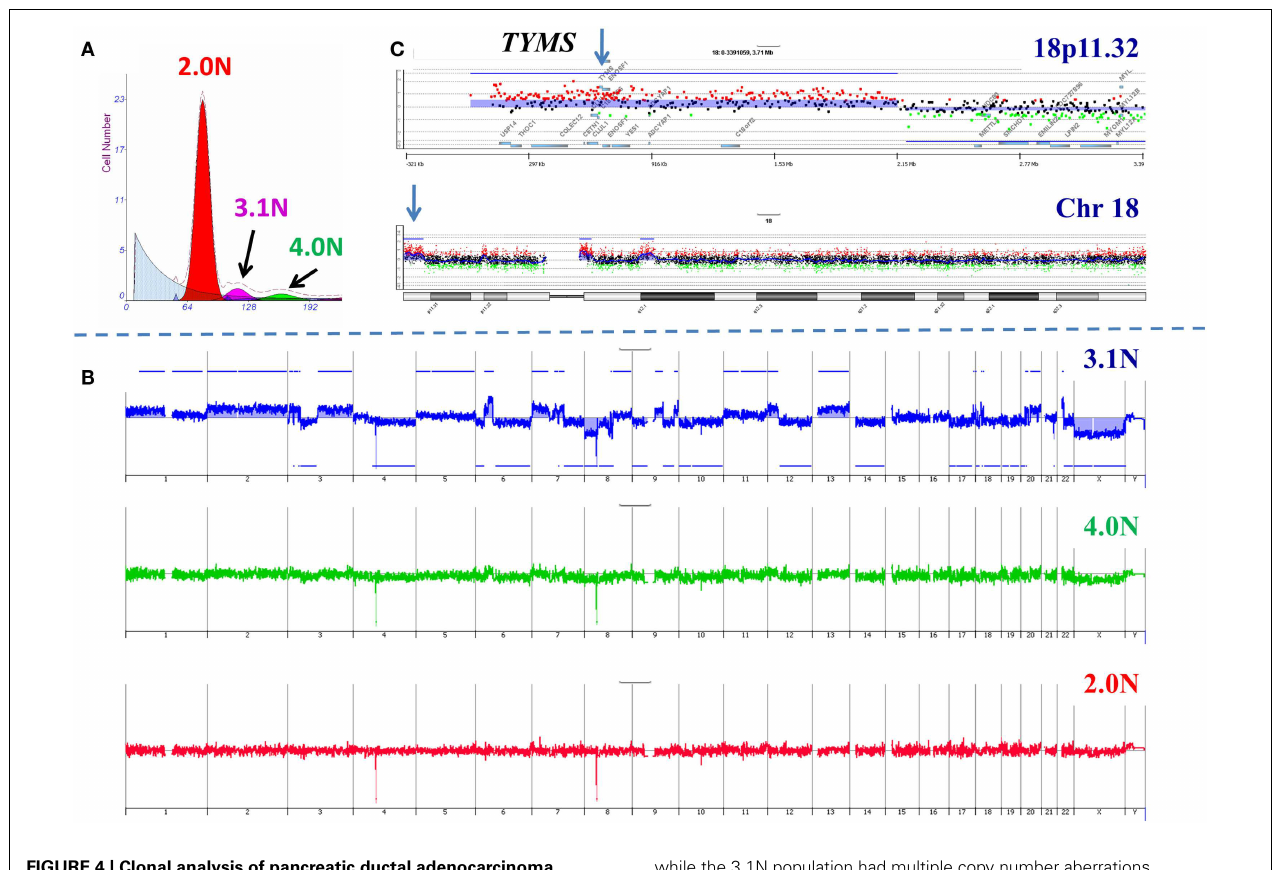
FIGURE 4 | Clonal analysis of pancreatic ductal adenocarcinoma (PDA) liver metastasis from SU2C clinical trial. (A) DNA content flow sorting identified and purified three distinct peaks in the single biopsy. (B) The 2.0N and 4.0N populations were genomically normal